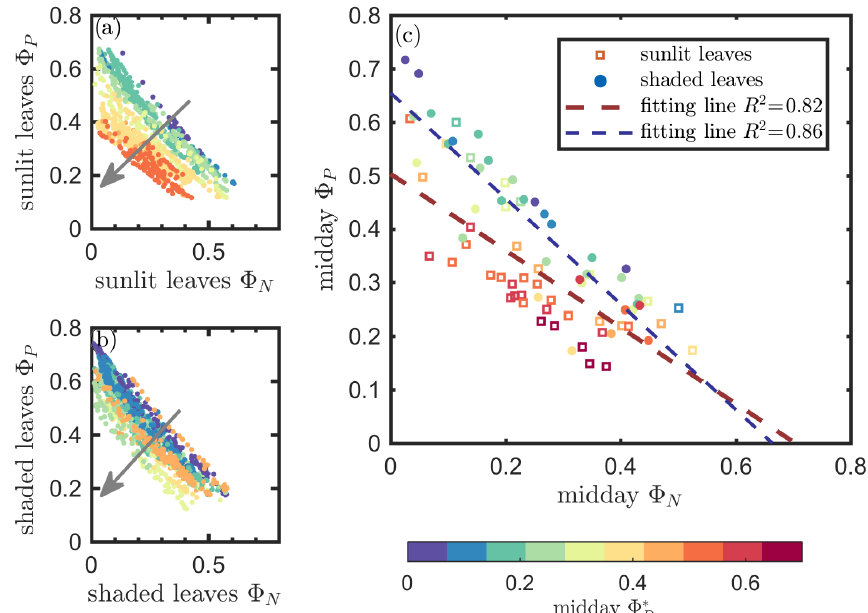
Figure 7. Relationships between the light use efficiency of photochemistry ( (cid:56) P ) and the reversible heat dissipation ( (cid:56) N ) for sunlit leaves and shaded leaves across the 2017 growing season in a corn canopy are shown, including all daytime measurements (09:00–17:00LT – a and b ) and midday (11:00–14:00LT), seasonally averaged measurements (c) . Colors refer to the midday (cid:56) ∗ indicate the shift in linear response between (cid:56) P and (cid:56) N as (cid:56) ∗